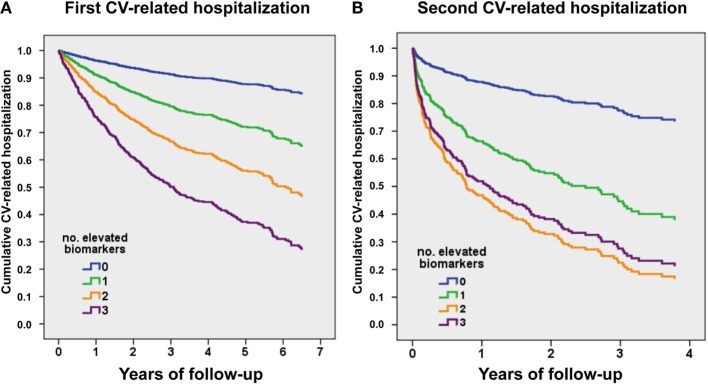
Event-free survival curves for CV-related recurrent hospitalizations, relative to the number of elevated biomarkers above the predefined cut-points. (A) First CV-related hospitalization. (B) Second CV-related hospitalization (from discharge date of the first CV-related hospitalization). hs-TnT > 14 ng/L, NTproBNP > 1000 ng/L, and ST2 > 35 ng/mL.